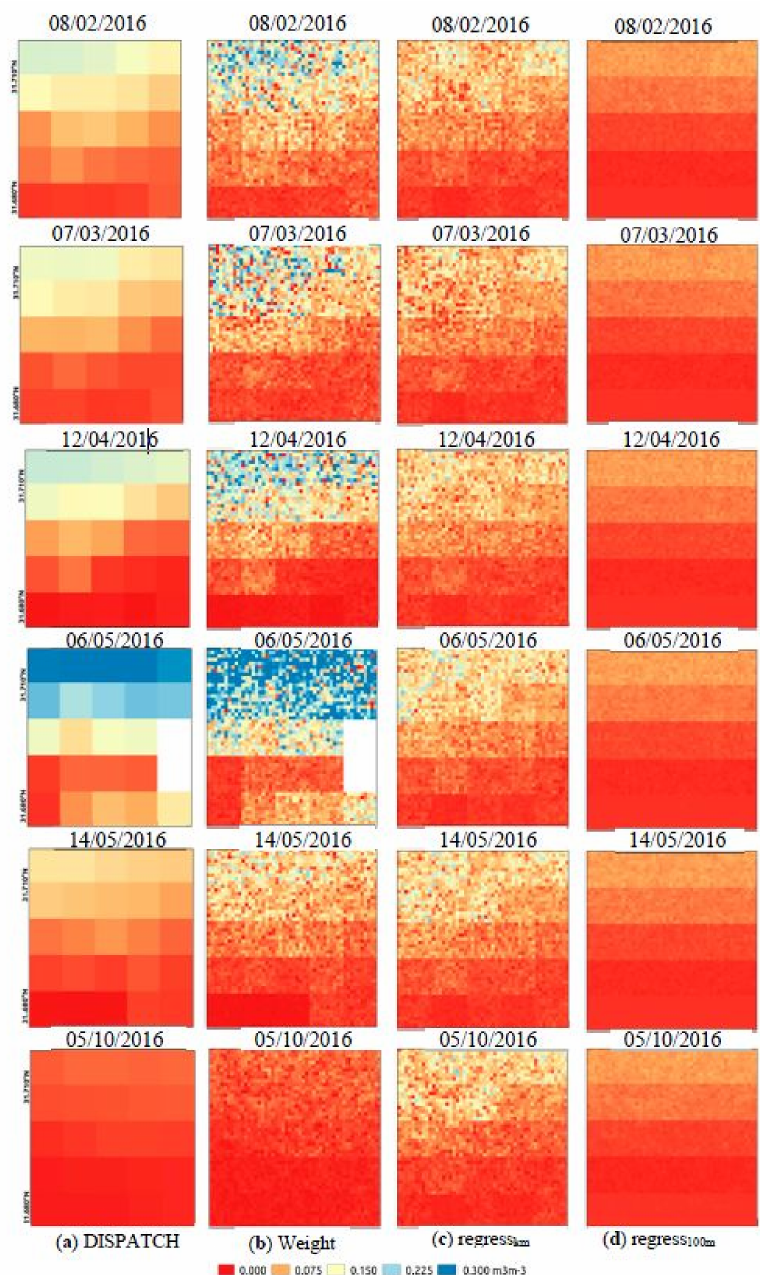
Figure 9. Spatial distribution of the 1 km DISPATCH product and disaggregated soil moisture over of the study area (5 km 2